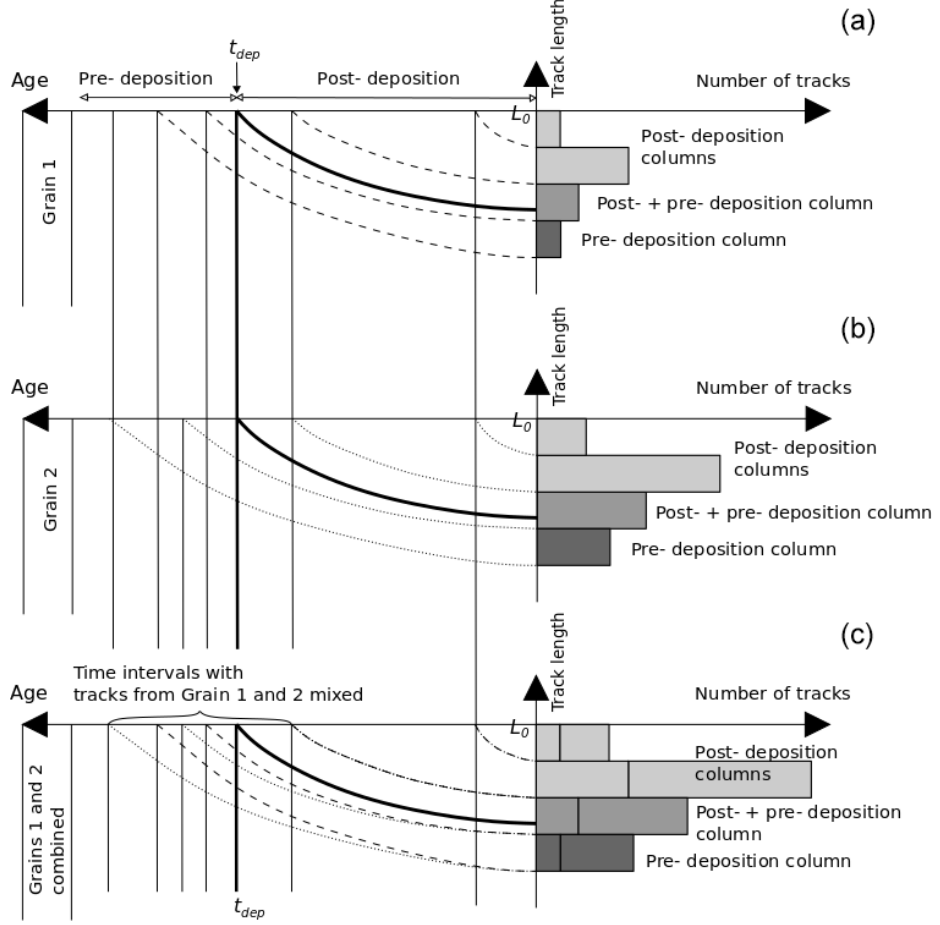
Figure 4. Sketch of the accumulation of simplified tracks in histogram columns. All tracks start with the length L 0 . Some tracks are generated before deposition and some after. The actual track lengths are reduced as a function of time. Panels (a) and (b) show Grain 1 and Grain 2 respectively, which have experienced a different pre-depositional thermal histories. Panel (c) displays the histogram for the bulk of grains 1 and